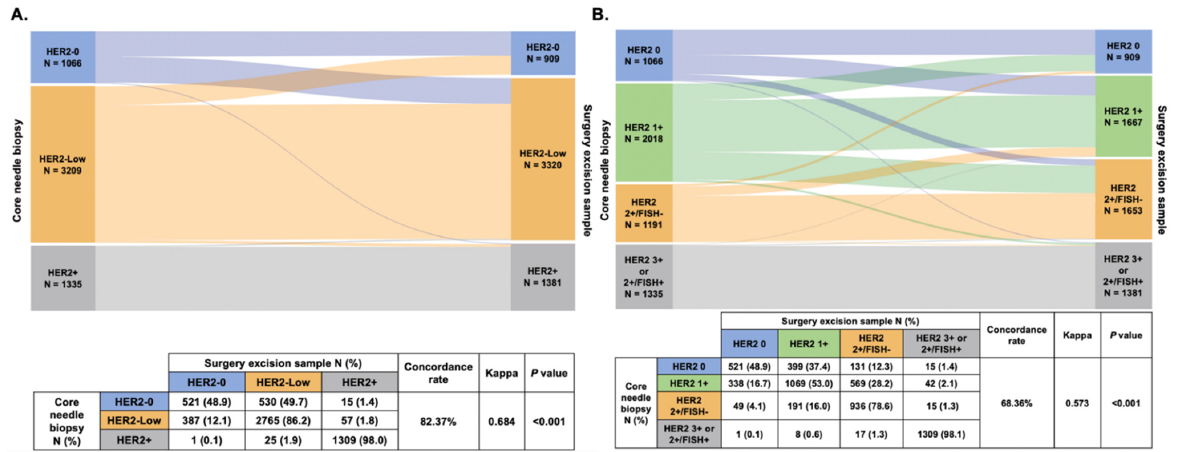
Figure 2. HER2 status change ( A ) and HER2 expression evolution ( B ) from core needle biopsy sample to surgical excision sample. Abbreviations: HER2, human epidermal growth factor receptor-2; FISH, fluorescence in situ hybridization.